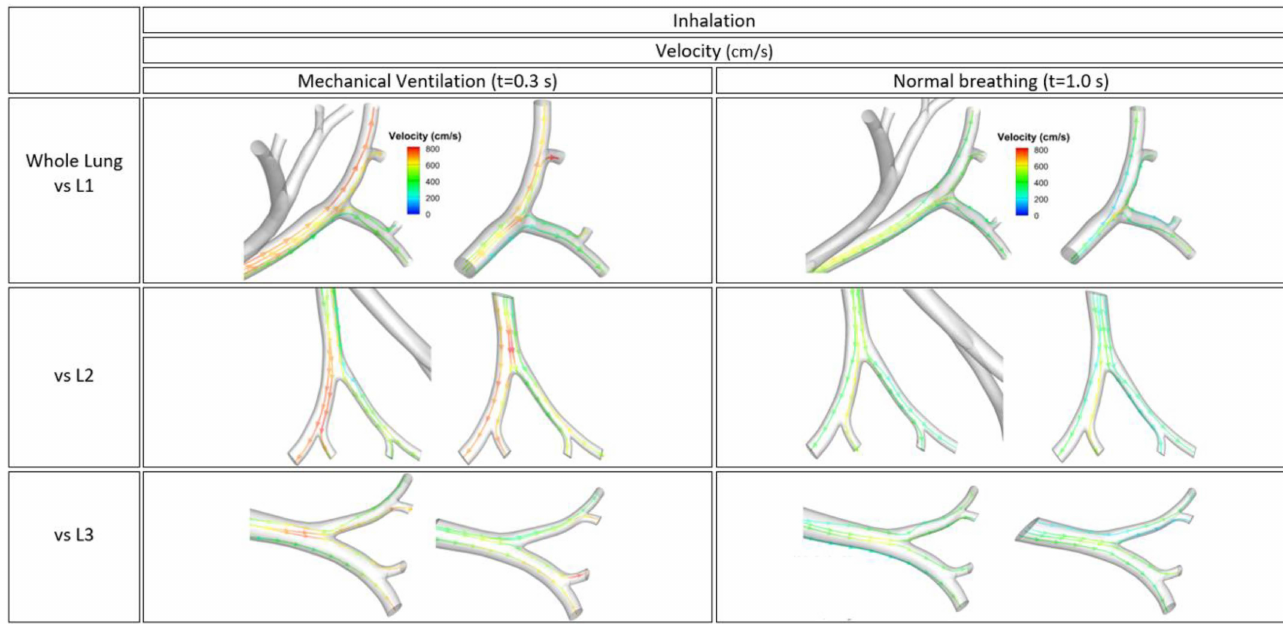
Figure 8. Comparison of airflow velocity for left bifurcations of whole lung and isolated local bifurcations (L1, L2, and L3). The plots are for the MV and NB during inhalation at t = 0.3 s, t = 1.0 s,